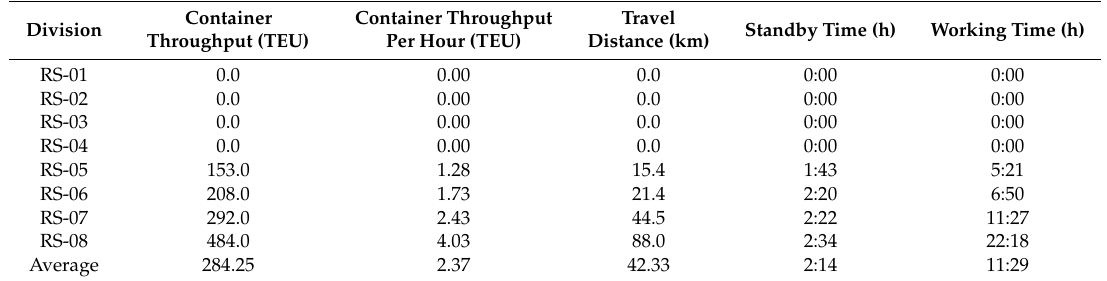
Table 3. Simulation results of virtualized port-container terminal (reach stacker).